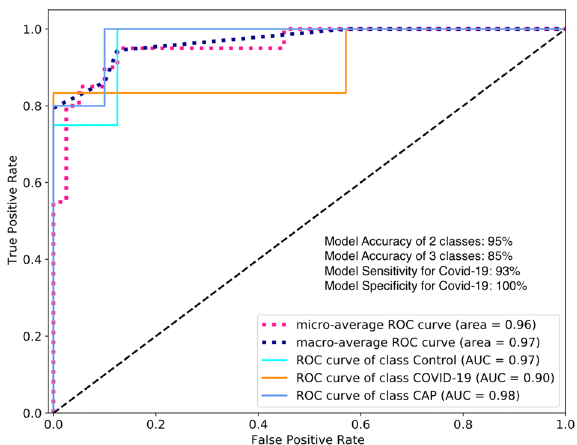
Fig. 5 Comparison of the outcome of CovidCTNet versus reader study. Performance of model and radiologists (reader) in a pool of chest CT dataset mixed of control, Covid-19 and CAP. AUC of Covid- 19 is 0.90 ( n = 20 cases). The accuracy, sensitivity, and speci fi city of readers versus model are shown. The model operation in three classes demonstrates the detection of all three classes including Covid-19, CAP, and control separately and in two classes indicates the detection of Covid-19 as one class versus CAP and control as second class. While macroaverage takes the metric of each class independently and computes their average, the microaverage computes the average metric after aggregating the contributions of all